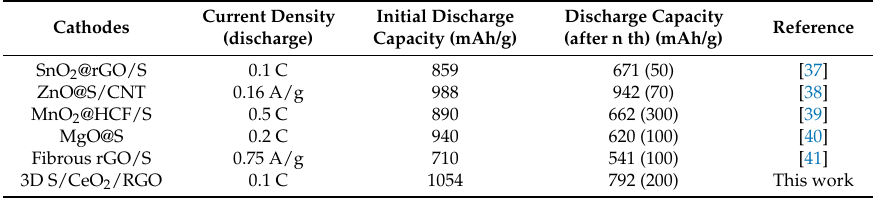
Table 1. Comparison of the electrochemical performances from previous reports and from our work. Cathodes